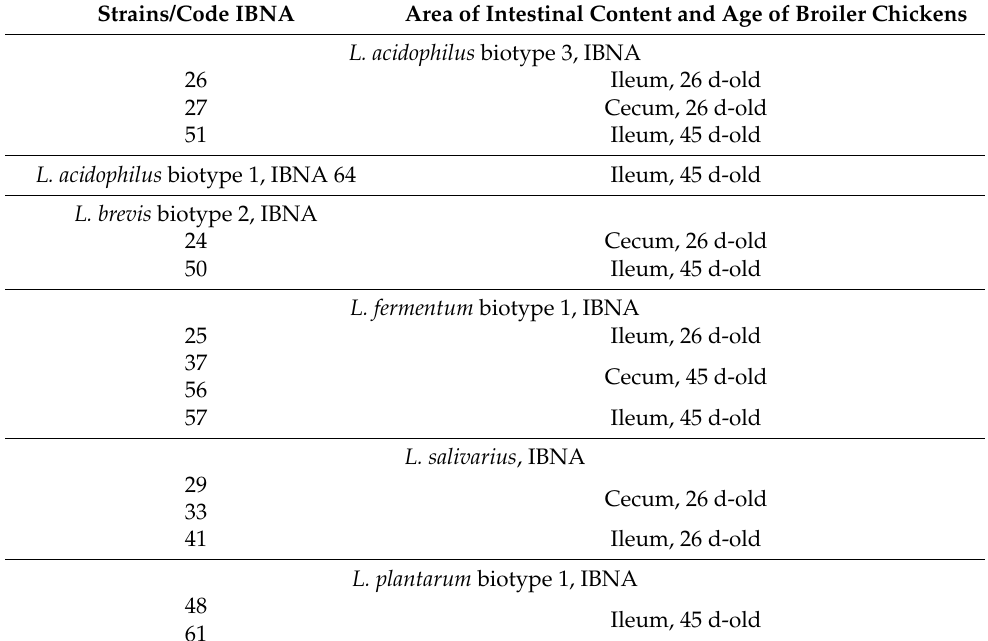
Table 1. The origin of Lactobacillus strains existence in broiler chickens GIT. Strains/Code IBNA Area of Intestinal Content and Age of Broiler Chickens L. acidophilus biotype 3,